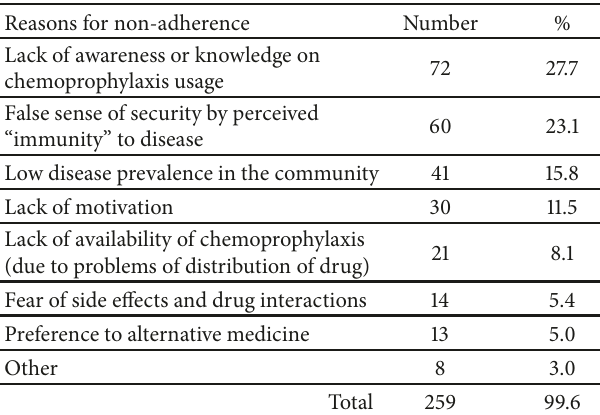
Table 5: Reasons for non-adherence or discontinuation of doxycy- cline